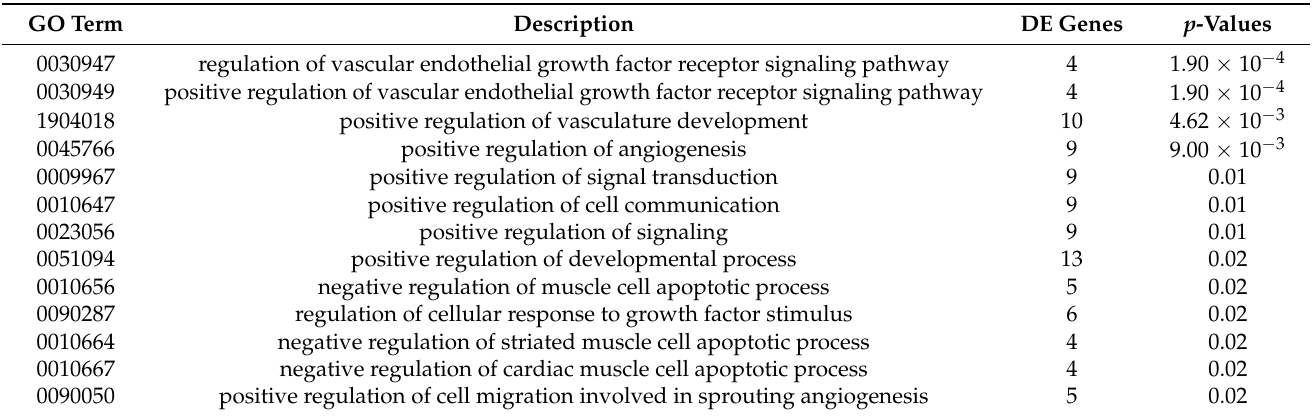
Table 2. GO enrichment analysis. GO enrichment analysis (biological process) of all differentially expressed miRNAs. Significant results include only differentially expressed genes DE > 2 with a p -value ≤